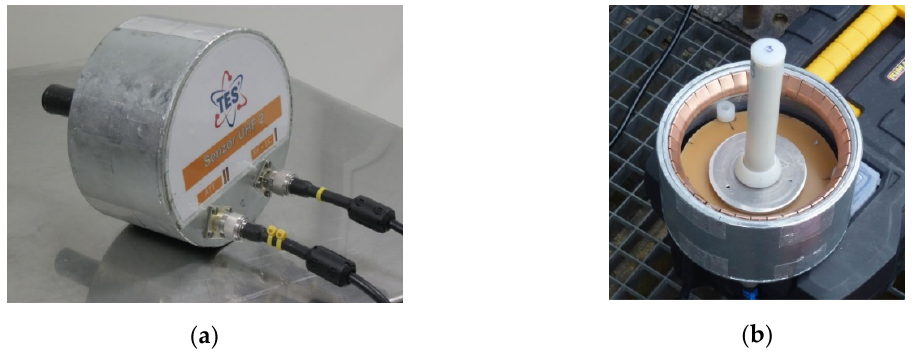
Figure 6. The PD UHF sensor unit: the rear ( a ) and front ( b ) sections.